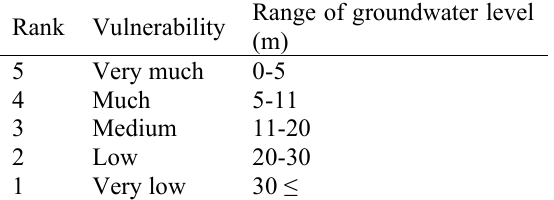
Table 4. Groundwater level layer vulnerability ranking